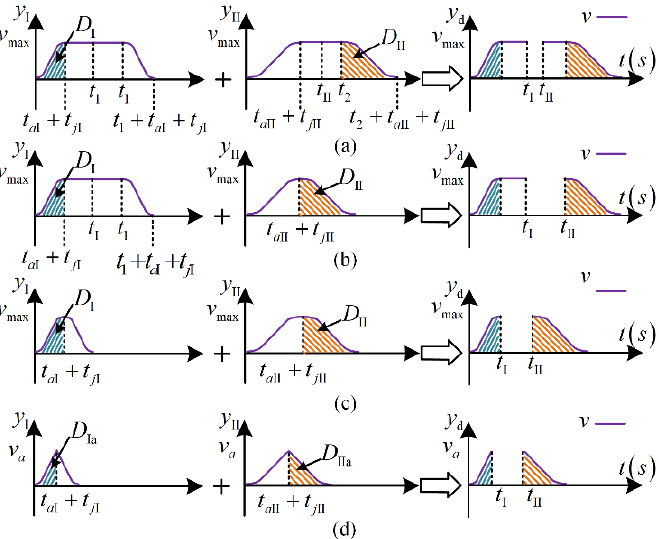
Figure 6. Convolutional dynamic-jerk-planning algorithm in different situations: ( a ) two phases of uniform motion, ( b ) one phase of uniform motion, ( c ) no uniform motion phases, and ( d ) no uniform acceleration phases.